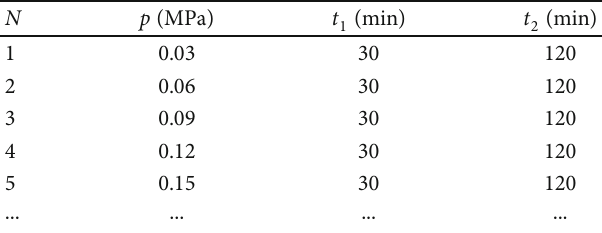
Figure 4: Production procedures of the physical model test: (a) boundary friction, (b) vibratory compaction, (c) water storage, (d) embedded sensor, (e) tunnel excavation, and (f) displacement meter arrangement. Table 2: Water pressure loading mode for simulating the wetting- drying cycle e ff